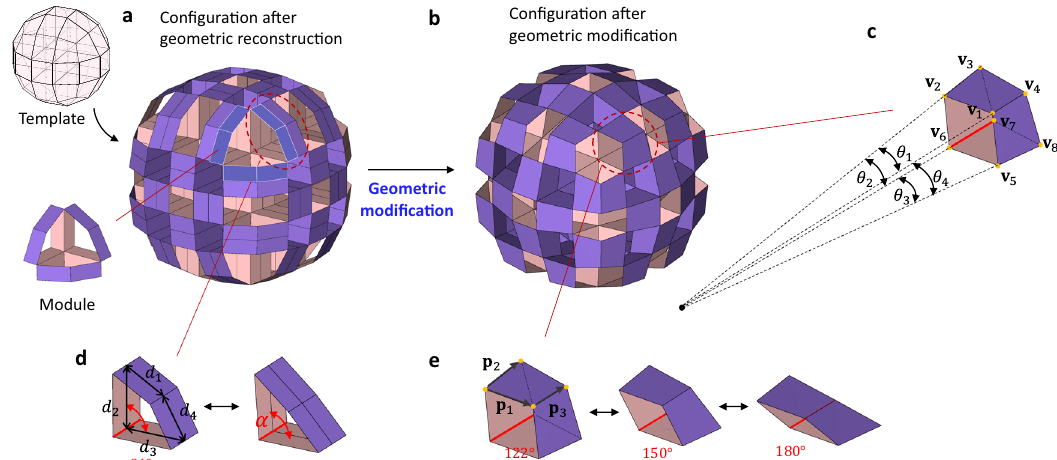
Fig. 2 | Geometric modi fi cation. a Initial con fi guration of modular origami structuresofaspheregeneratedbyvolumetricmappingandvolumetricshrinkage 3×3×3 ð Þ of a cubic unit cell. Note that modules can be built by selective tubular extrusionofshrunkenpolyhedrons. b Con fi gurationaftergeometricmodi fi cation. Equations (4) and (5) produce the constraints for the rectangular tubes, i.e., d d d θ θ θ θ d 1 = 2 = 3 = 4 and 1 = 2 = 3 = 4 . c A tube with intersecting hinges, where the angle between the projected